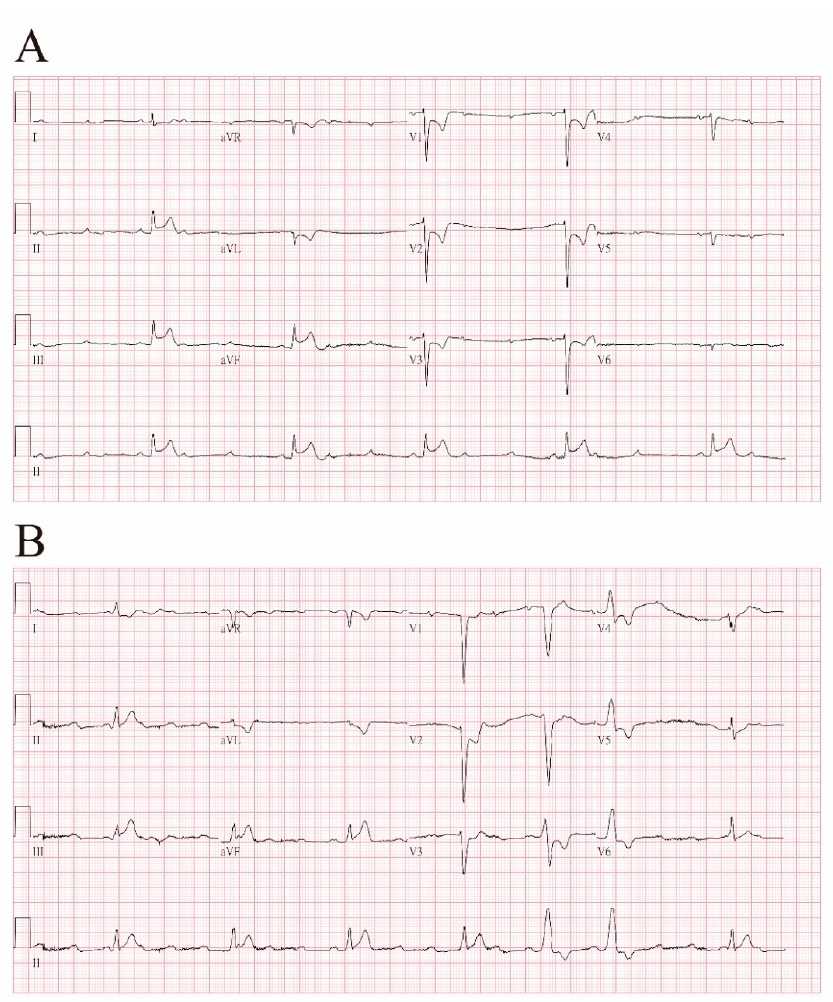
Figure 3. Fifteen minutes after the administration of contrast media, ( A ) ECG showed progressive bradycardia with ST segmental elevation at leads II, III, and aVF, and ST segmental depression at V1 to V6. ( B ) Right side ECG revealed bradycardia with ST segmental change at V2 to V6. The emergency administration of Atropine 0.5 mg and Betamethasone 4 mg was given.